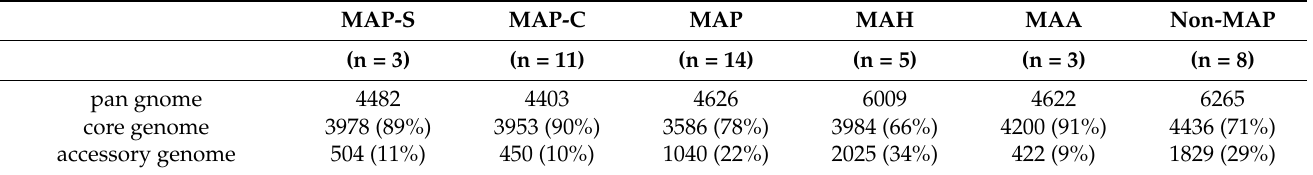
Table 7. Number of genes in the pan genomes of MAP-S, MAP-C, MAH, and MAA. The pan genome is subdivided into core and accessory genomes. The calculation based on analyses by EDGAR, which was also used for results shown as Venn diagrams in Figure